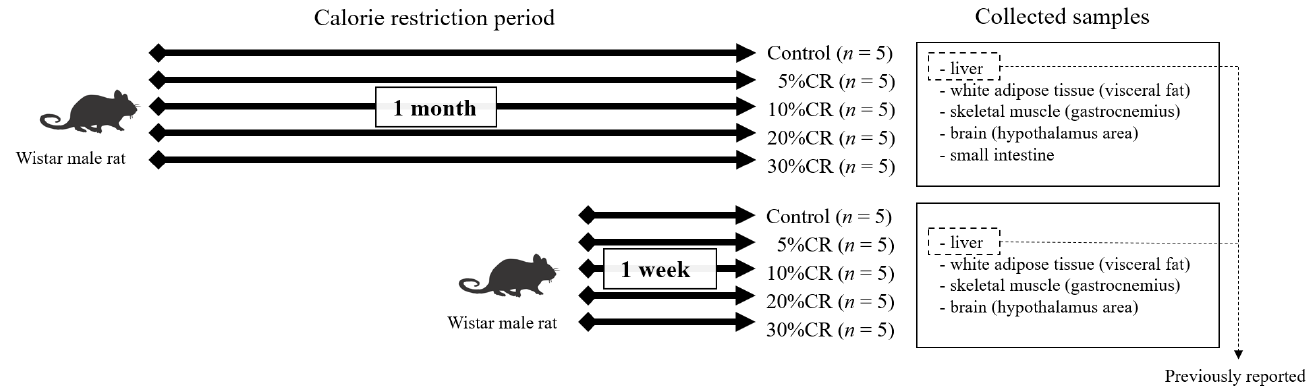
Figure 1. Overview of the animal experiment.